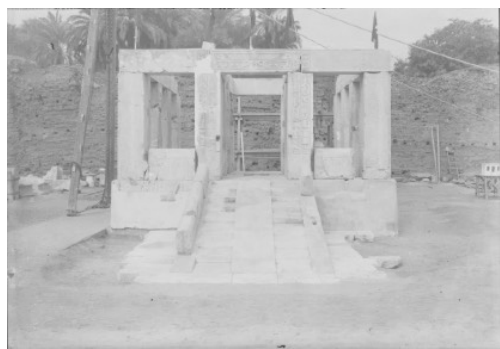
Figure 3 . Glass plate photograph during the anastylosis from Henri Chevrier in 1938 (n°16840).